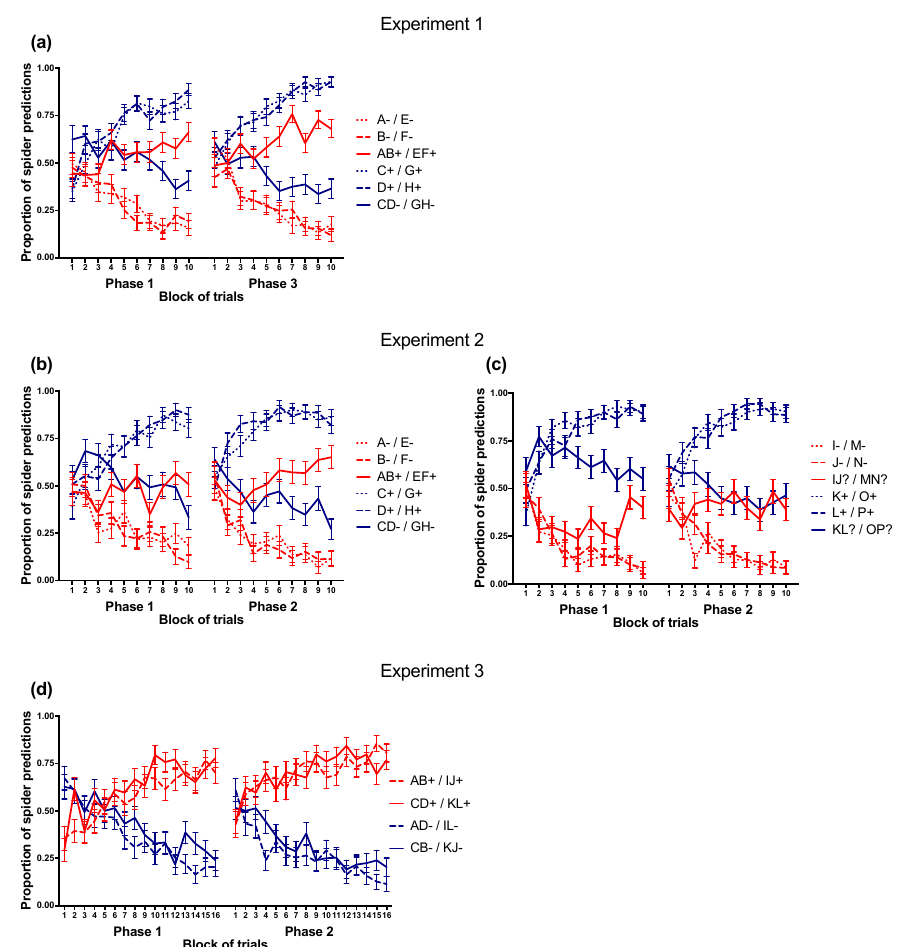
Figure 2. Average trial-by-trial predictions in the learning tasks. Spider predictions were coded as 1 and no-spider predictions were coded as 0. Error bars represent the standard error of the mean. The left panels show the performance on trials from the training sets in ( a ) Experiment 1, ( b ) Experiment 2 and ( d ) Experiment 3. The right panel ( c ) shows the performance on trials from the transfer set in Experiment 2. Table 3. Correlations Between Learning Measures and Fluid Abilities 1 .